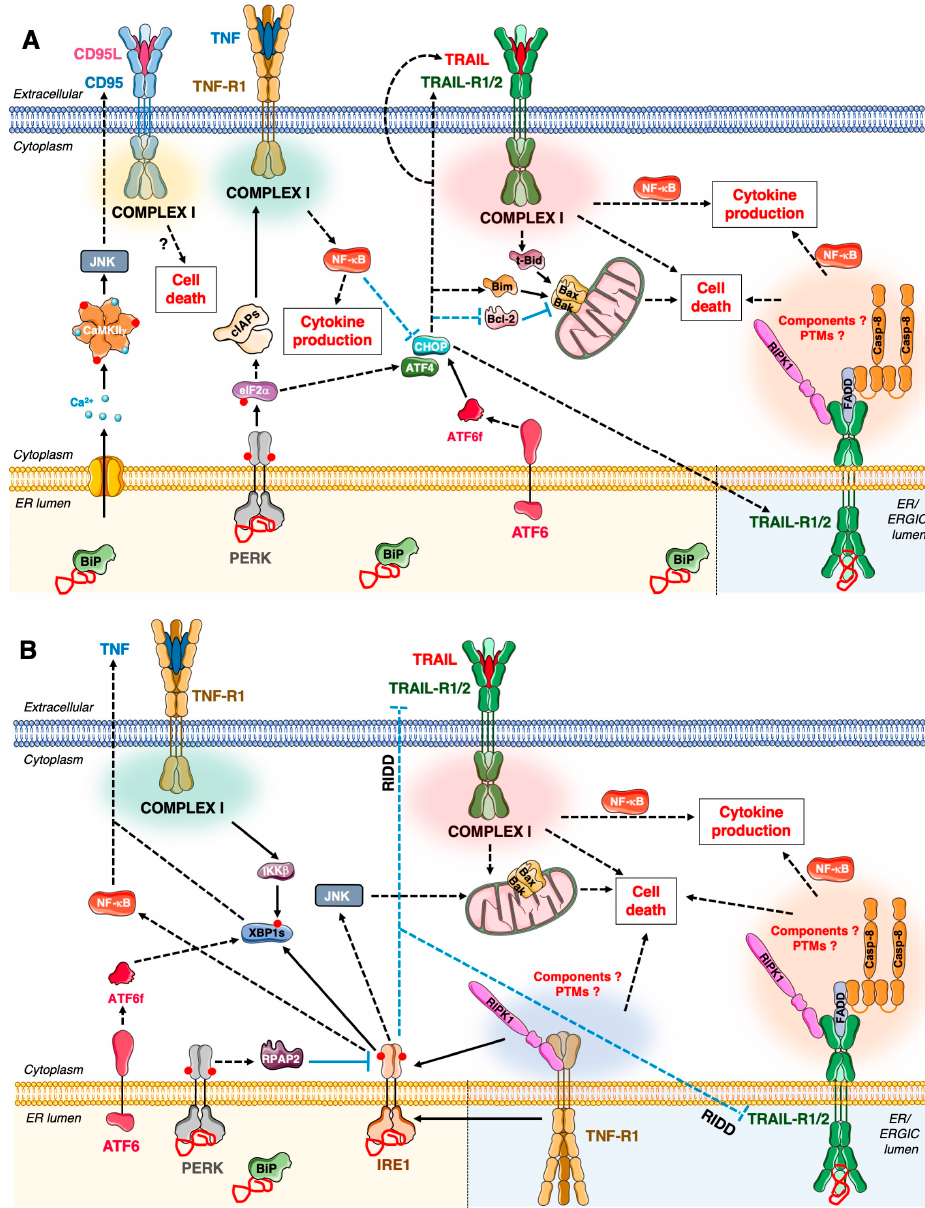
Figure 4. Functional links between DR signalling and UPR. A . Focus on the Protein kinase RNA-like Endoplasmic Reticulum Kinase (PERK)-DR signalling cross-talks. TRAIL-R1 / 2 contribute to ER-stress-induced death, including via the mitochondrial branch in certain cell types, as well as ER-stress-induced cytokine production. Whether or not it is also involved in additional UPR-mediated signalling outcome is not known. TRAIL-R1 / 2 accumulate at the ER or the ER-Golgi Intermediate Compartment (ERGIC) membrane upon ER stress, from which they mediate signalling. TRAIL-R2 oligomerisation in these compartments was recently proposed to be mediated by direct unfolded protein binding. The composition of the TRAILR-associated complex(es) in these intracellular compartments and the mode of regulation of this signal remain to be investigated. B . Focus on the Inositol-Requiring Enzyme-1 (IRE1)-DR signalling cross-talks. Through the RIDD, IRE1 represses TRAILR-dependent signalling. IRE1 activity is regulated by multiple mechanisms including its putative interactions with TNFR1, RIPK1, and via RNA Polymerase II Associated Protein 2 (RPAP2)-mediated dephosphorylation. (See text for further details on depicted cross-talks and Figures 1–3 for details on Complexes 1 and initiation of UPR signalling.)